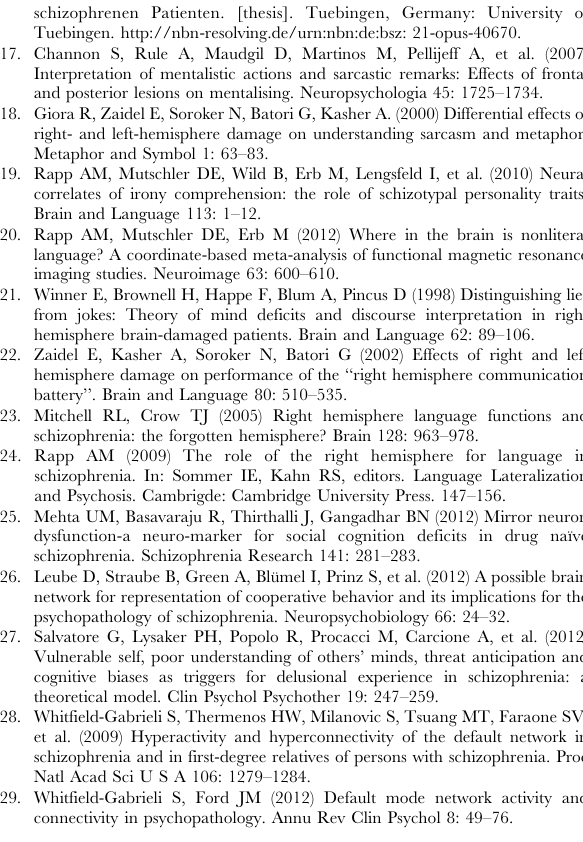
Figure S1 Group comparison between healthy controls and schizophrenia for ironic sentences . visual baseline. Slice view. p , 0.001, ext. 5 voxels. Controls . schizophrenia activation is marked red, Strongest maxima in the posterior part of the anterior cingulate (ACC) and the LH anterior insula. Schizophrenia . controls is marked blue, strongest activation is in the LH parahippocampal gyrus. Table S1 Correlation analysis between fMRI signal during irony comprehension and schizotypal personal- ity traits. Correlations are shown across all study participants independent of diagnosis. p , 0.001, ext. 5 voxels. Table shows correlations with ‘‘interpersonal’’ and ‘‘cognitive perceptual’’ subscales of the schizotypal personality questionnaire, German version [67]. A negative correlation indicates that the higher the degree of psychometric schizotypy, the lower is the BOLD response. Total score of the schizotypal personality questionnaire showed negative correlation in the posterior medial prefrontal cortex (MNI 3 18 33, z =3,34, extent 5 voxel) for reading ironic sentences . visual baseline), all other correlations were not